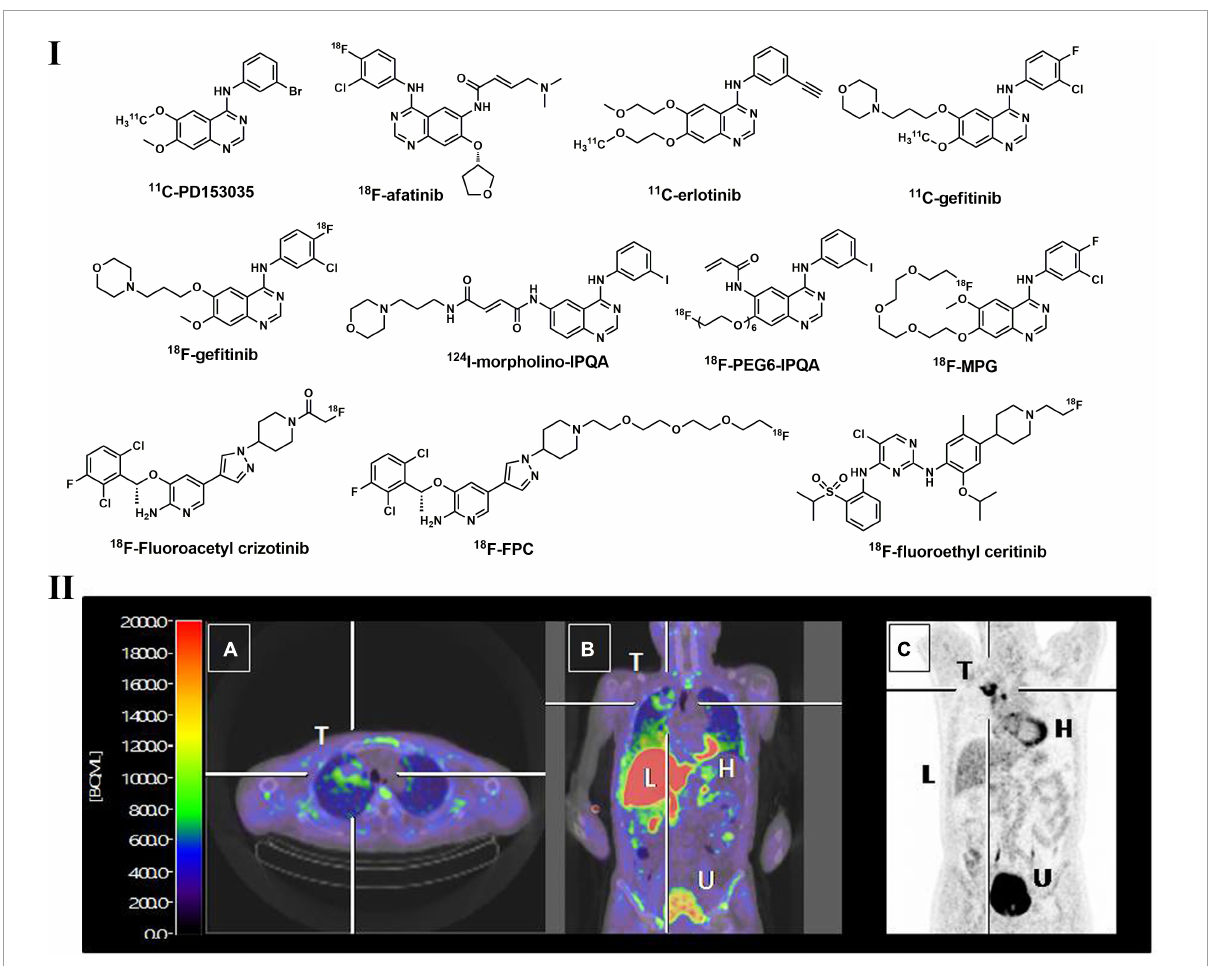
FIGURE5 Structures of representative radiolabeled TKIs used in lung cancer imaging (I) and PET images of 18 F-afatinib in a NSCLC patient with EGFR 19_del (II) . Tumor with EGFR 19_del can be clearly visualized by 18 F_afatinib (T: tumor; H: heart; L: liver; U: urinary